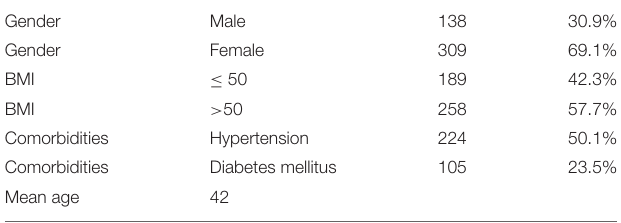
TABLE 1 | Patient